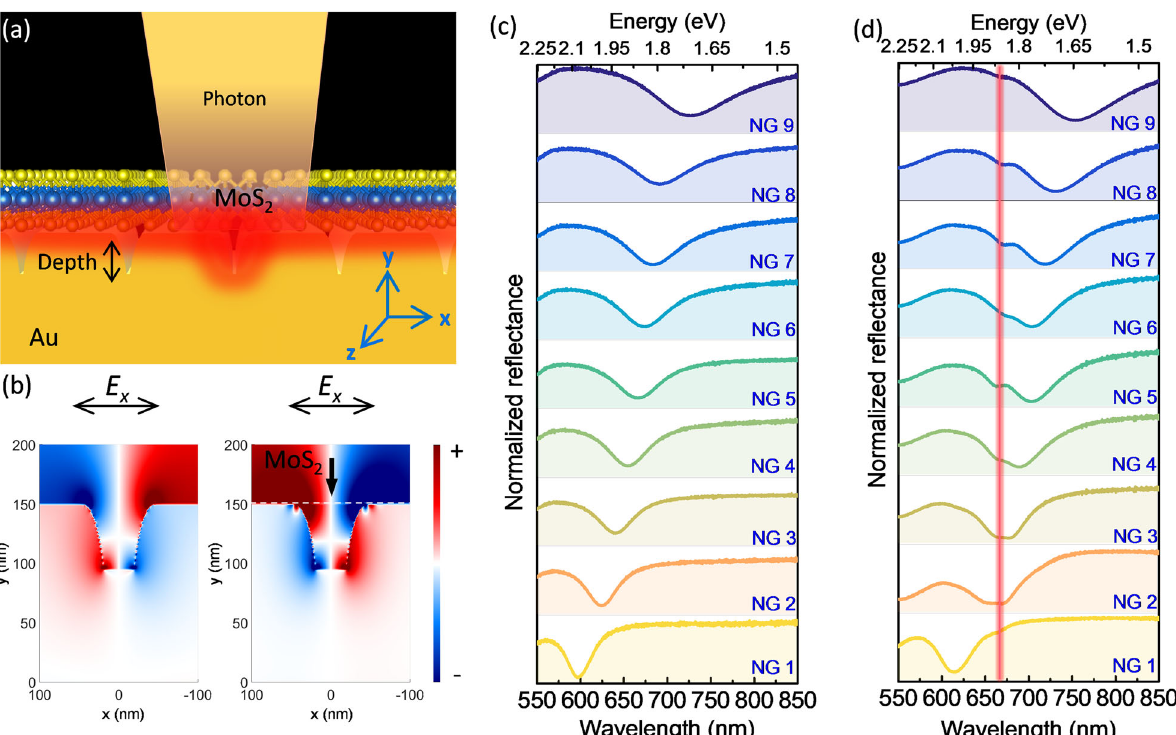
Fig. 2 Features of plexciton system in individual Au NG array. a Au NGs load MoS 2 monolayers on their top. b The simulated electric- fi eld distributions of the plasmon-coupled mode of Au NGs (left panel) and loading monolayers MoS 2 (white dashed line) on top (right panel). The incident light is polarized along the x -axis. The re fl ectance spectra of: c the Au NGs having various depths, and d the Au NGs upon integrating MoS 2 on their